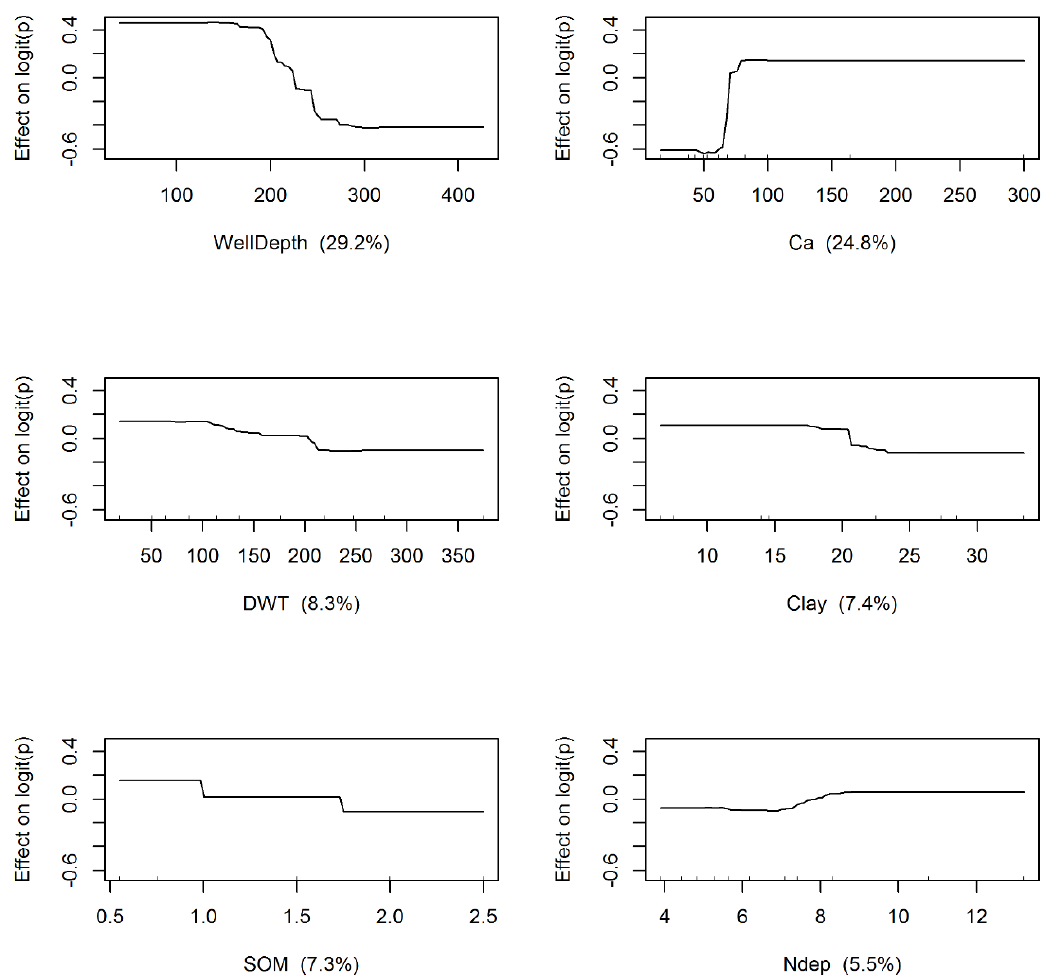
Figure 5. Effects of Salient Model Parameters on Computed Logit for the Gradient Boosting Trees (GBT) Algorithm.